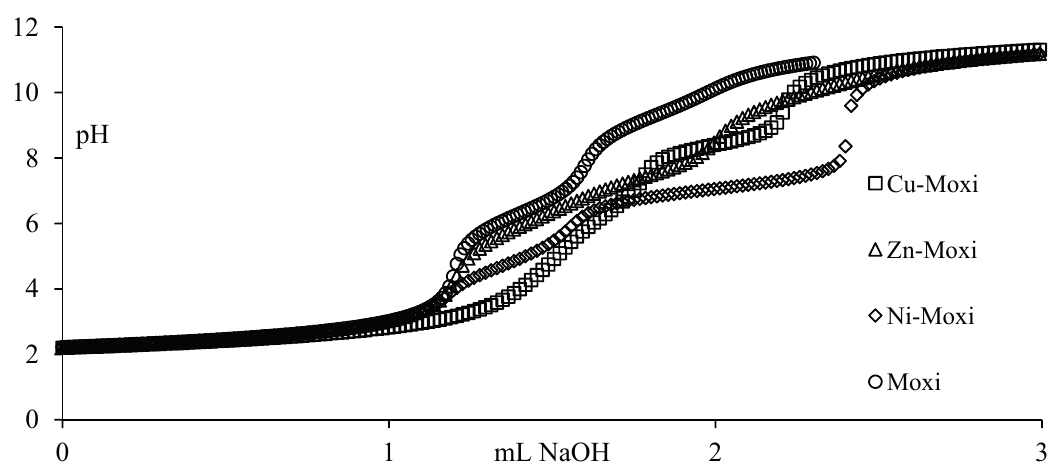
Figure 1. Titration curves for moxifloxacin and moxifloxacin + metal cations with NaOH at 310 K and I = 0.15 M (NaCl). Concentration of metal cations: 1.0 mmol/L, concentration of moxifloxacin: 2.0